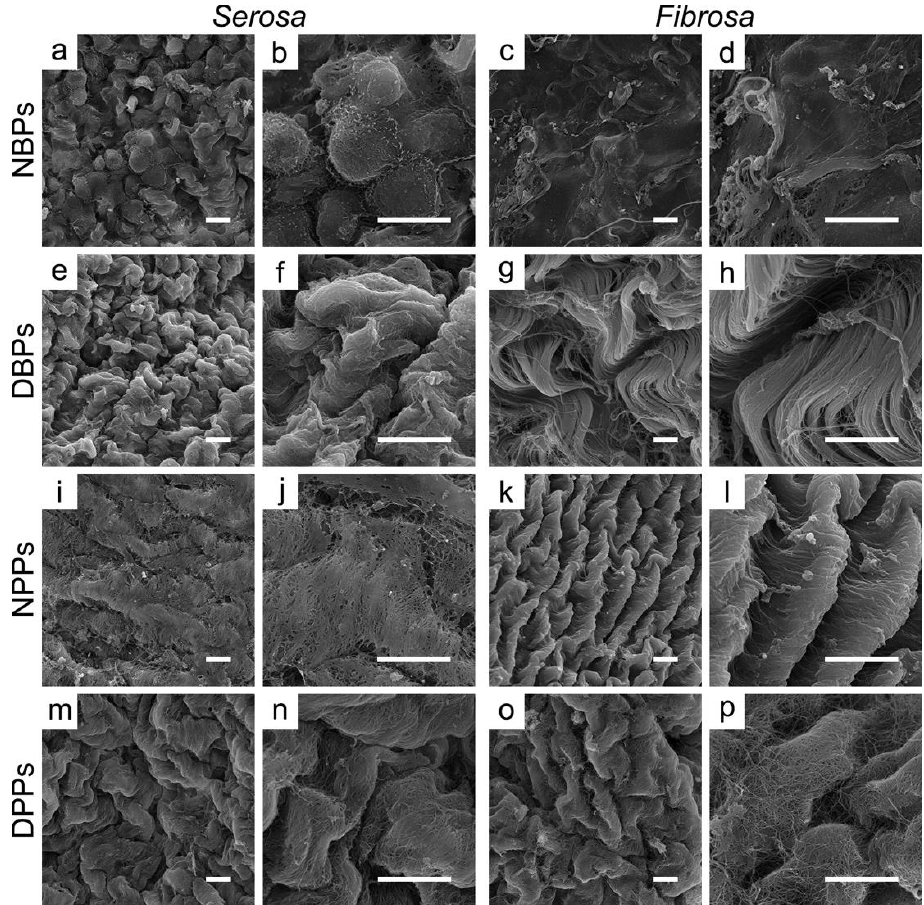
Figure 3. Ultrastructural properties of bovine and porcine pericardia before and after TRICOL decellularization. The mesothelial cell lining of the serosa side of bovine (a and b) and porcine (i and j) pericardia was removed after decellularization (e and f for bovine; m and n for porcine). The collagen bundles were loosened in the native bovine fibrosa (c and d), becoming more organized after decellularization (g and h), while they were crimped for the porcine counterparts (k and l for native; o and p for decellularized). Magnification bars: 10 µm. NBP = Native Bovine Pericardium, DBP = Decellularized Bovine Pericardium, NPP = Native Porcine Pericardium, and DPP = Decellularized Porcine Pericardium.